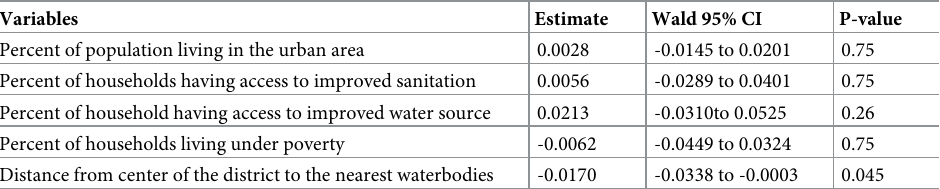
Table 3. Results of the analysis using zero inflated negative binomial model (ZINB) model. Variables